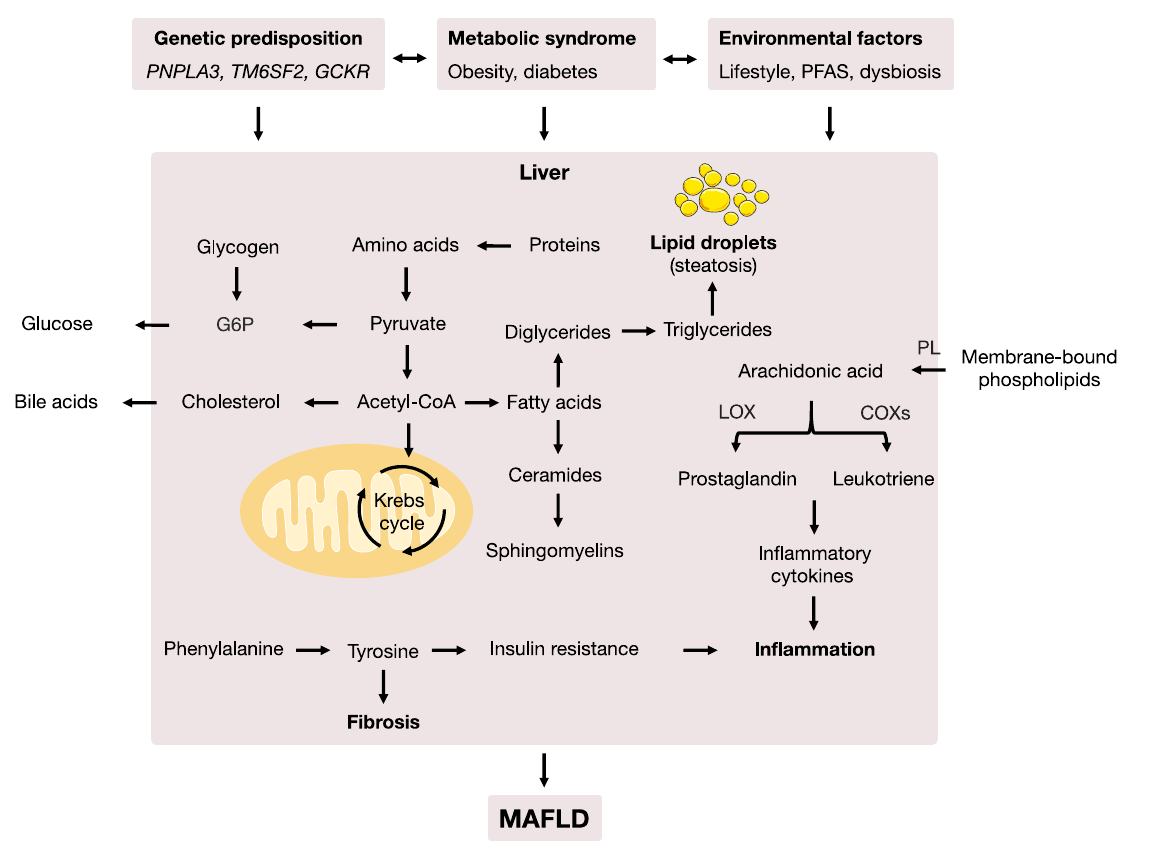
Figure 6. The potential cross-talk between different factors and biological pathways involved in the development of MAFLD. MAFLD is a complex disease that involves dysregulations in multiple biological pathways, specifically amino acid, arachidonic acid, bile acid and lipid metabolism, which is modulated by interactions between genetic predisposition, metabolic syndromes and environmental factors. Note: acetyl-CoA, acetyl coenzyme A; G6P, glucose 6-phosphate; PFAS, perfluorinated alkyl substances; COXs, cyclooxygenases; LOXs, lipoxygenases; PL, phospholipase; PNPLA3 , patatin-like phospholipase domain-containing protein 3 gene; TM6SF2 , transmembrane 6 superfamily member 2 gene; GCKR , glucokinase regulatory protein gene. Partially inspired by Masoodi et al. [18]. The mitochondrion and lipid droplets illustrations were adapted (modified with layer and text) from Servier Medical Art. Servier Medical Art by Servier is licensed under a Creative Com ‐ mons Attribution 3.0 Unported License (https://creativecommons.org/licenses/by/3.0/ accessed on 1 October 2022).